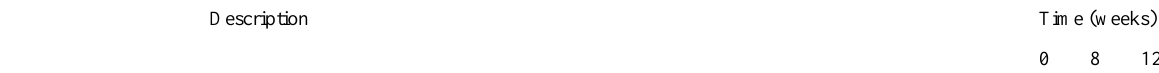
Table 2. For specific aim 1, study outcomes will be assessed pretreatment (week 0 at evaluation session 1), after completion of education combined with exercise (week 8 at evaluation session 2), and after 4 weeks of continuing the home exercise program at home (week 12 at evaluation session